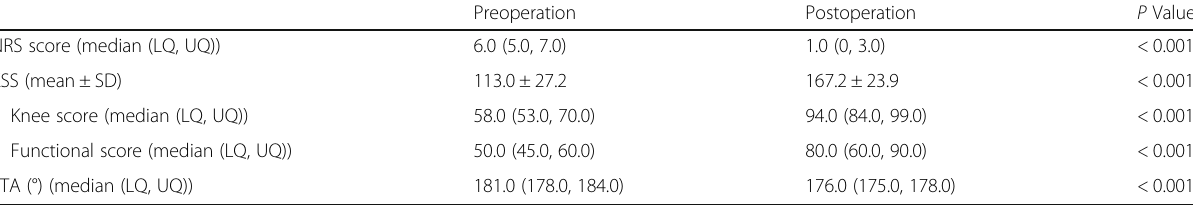
Table 1 Preoperative and postoperative demographics of 87 cases of unicompartmental arthroplasty knee (UKA) Preoperation Postoperation